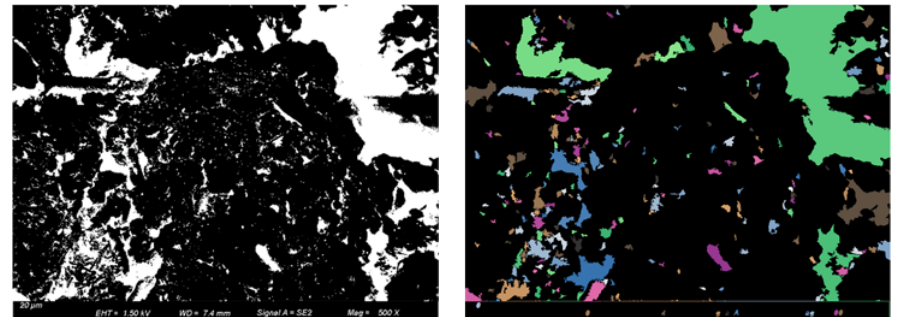
Figure 6. Pore microstructure of loess cured by MICP. ( a ) Loess solidify at 4000 times; ( b ) MICP curing loess mode; ( c ) Loess solidify at 2000 times.